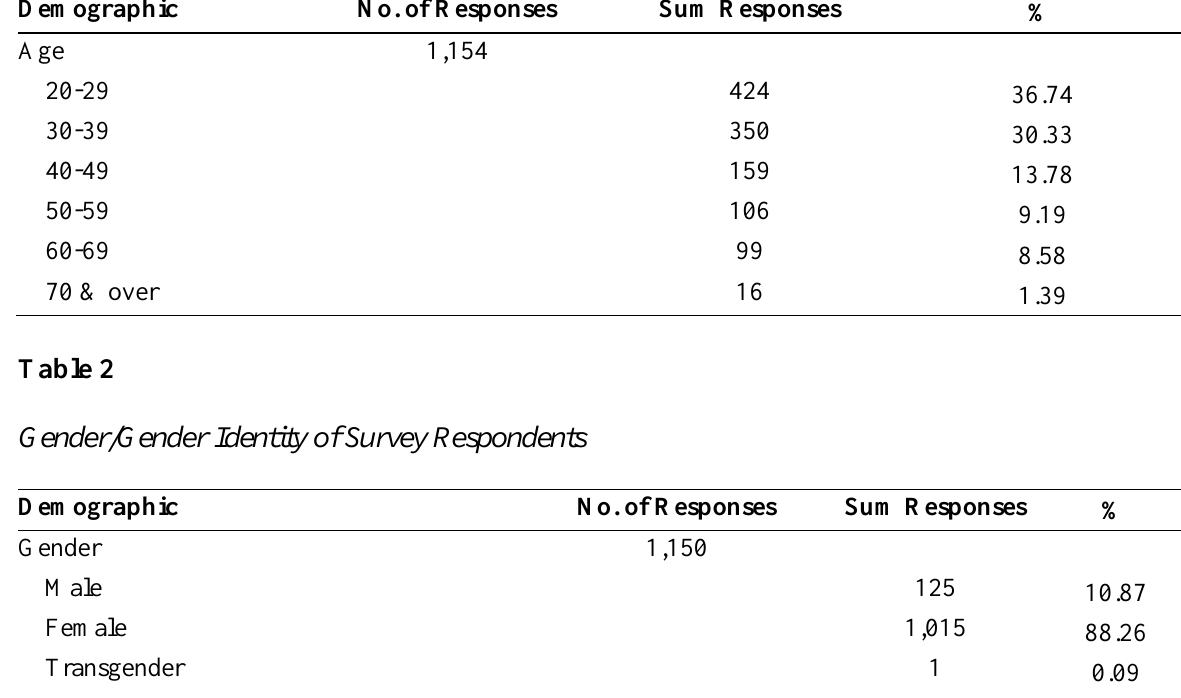
Age Distributions of Survey Respondents Demographic